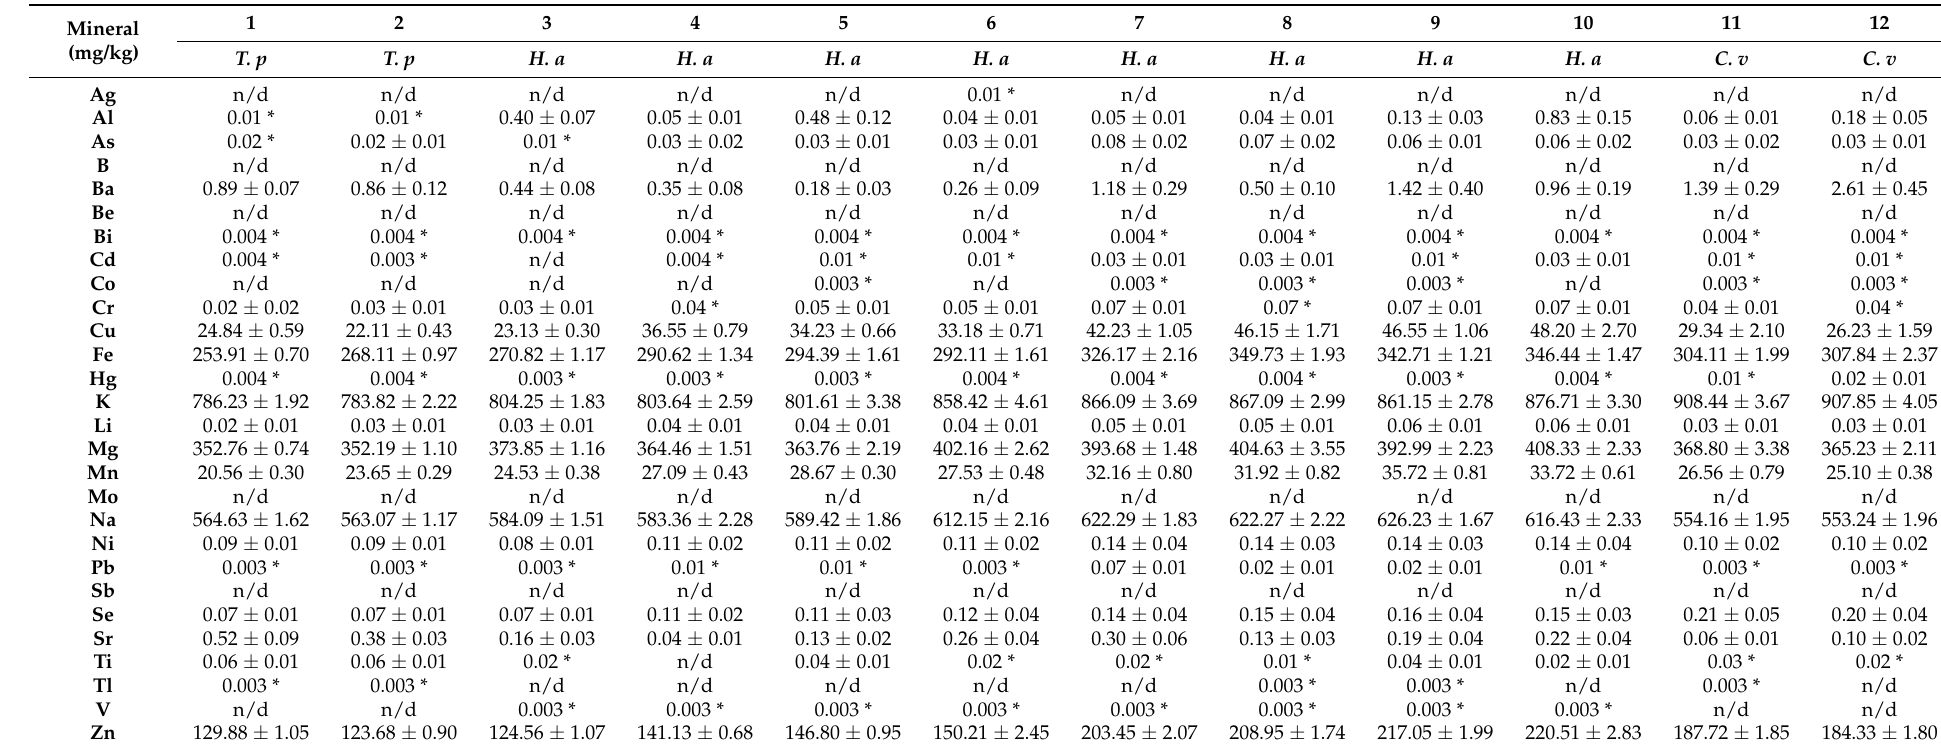
Table 3. Mineral contents in edible parts of gastropod samples, expressed as